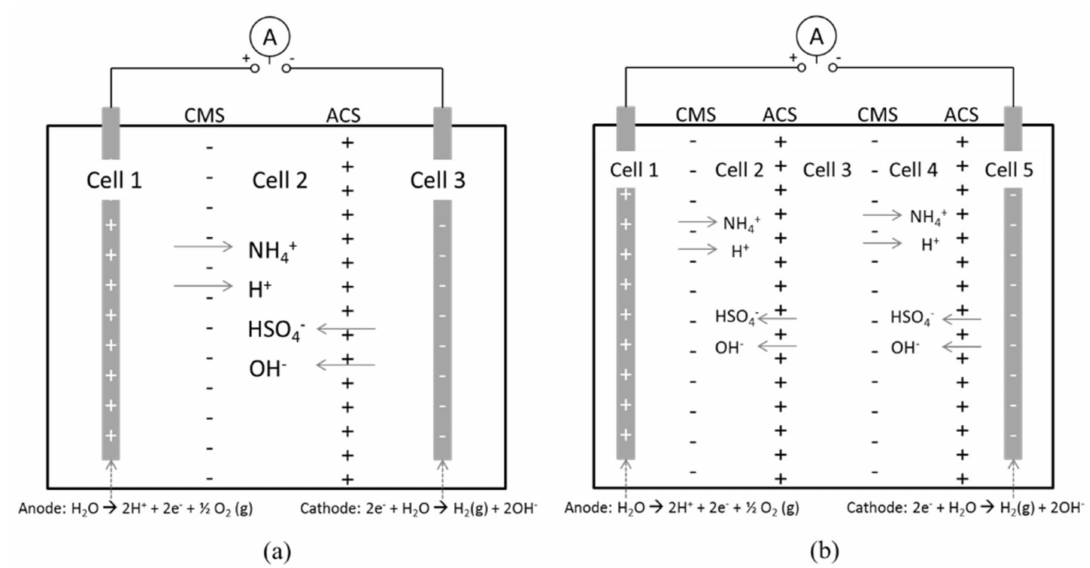
Figure 2. Schematic sketch of the principle of the experimental setup. ABS (NH 4 + , HSO 4 − ) will be transported to the middle section ( a ) or to the second and fourth cell ( b ) as a DC current is applied to the stack.